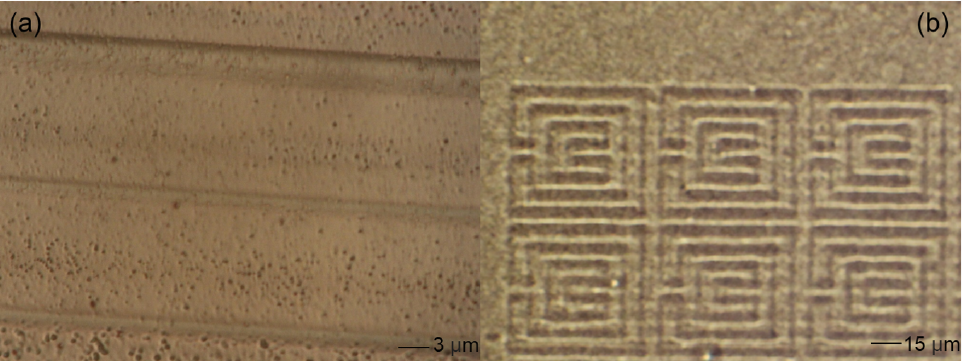
Figure 4. ( a ) Optical microscopic view of the surface immediately after the laser patterning and selective polymerization with a line pattern of width 10 µ m. ( b ) Image of the selective polymerized surface with a complex structure of the